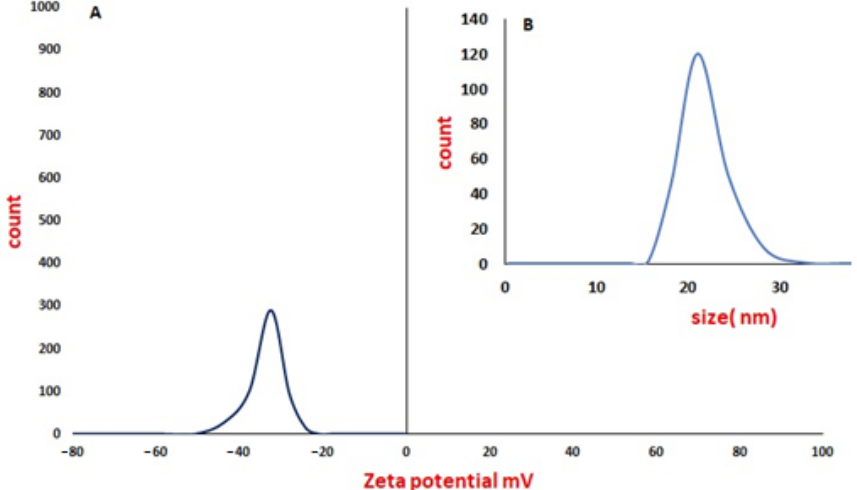
Figure 5. Zeta potential of silver nanoparticles ( A ) and DLS of silver nanoparticles ( B